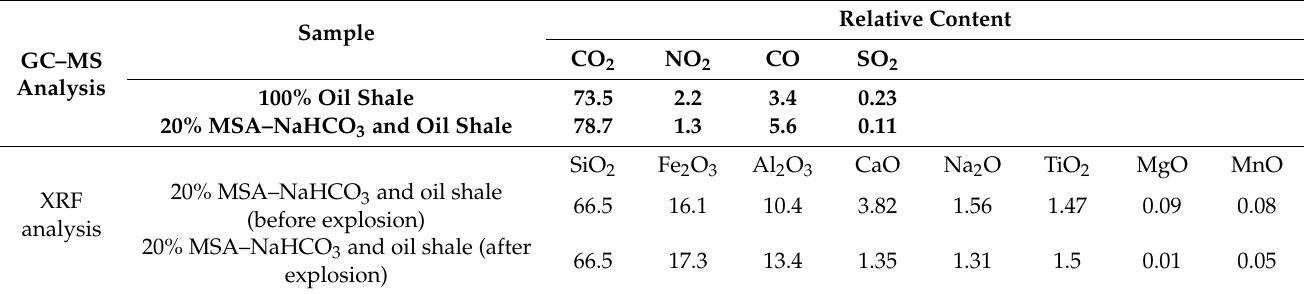
Table 6. Composition analysis of explosion